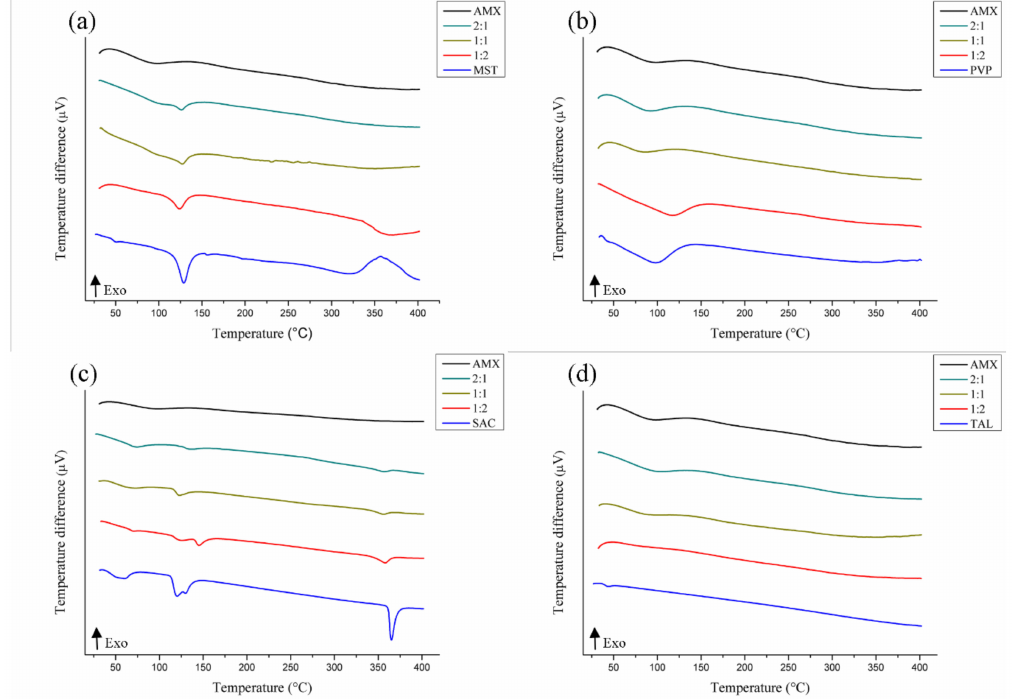
Figure 4. DTA curves of the binary mixtures of AMX and pharmaceutical excipients: magnesium stearate ( a ), polyvinylpyrrolidone K-30 ( b ), sodium saccharin ( c ), and talc ( d